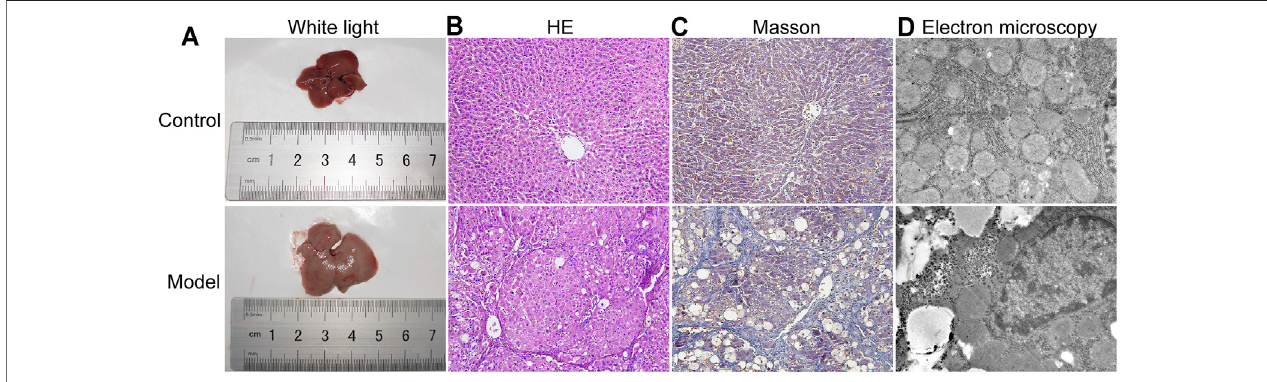
FIGURE2| Collectedliversweresubjectedtopathologicalanalysisbywhitelight,HEandSiriusredstainingandtransmissionelectronmicroscopy. (A) Liverunder white light. (B) HE staining (200-fold). (C) Sirius Red staining (200-fold). (D) Transmission electron microscopy (TEM) analysis (20000-fold).